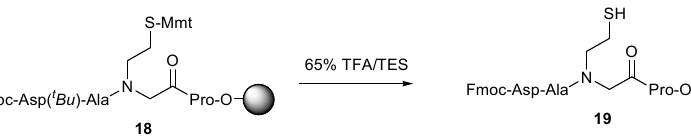
Scheme 4 . Synthesis of S -free/completely unprotected peptide–peptoid 19 .